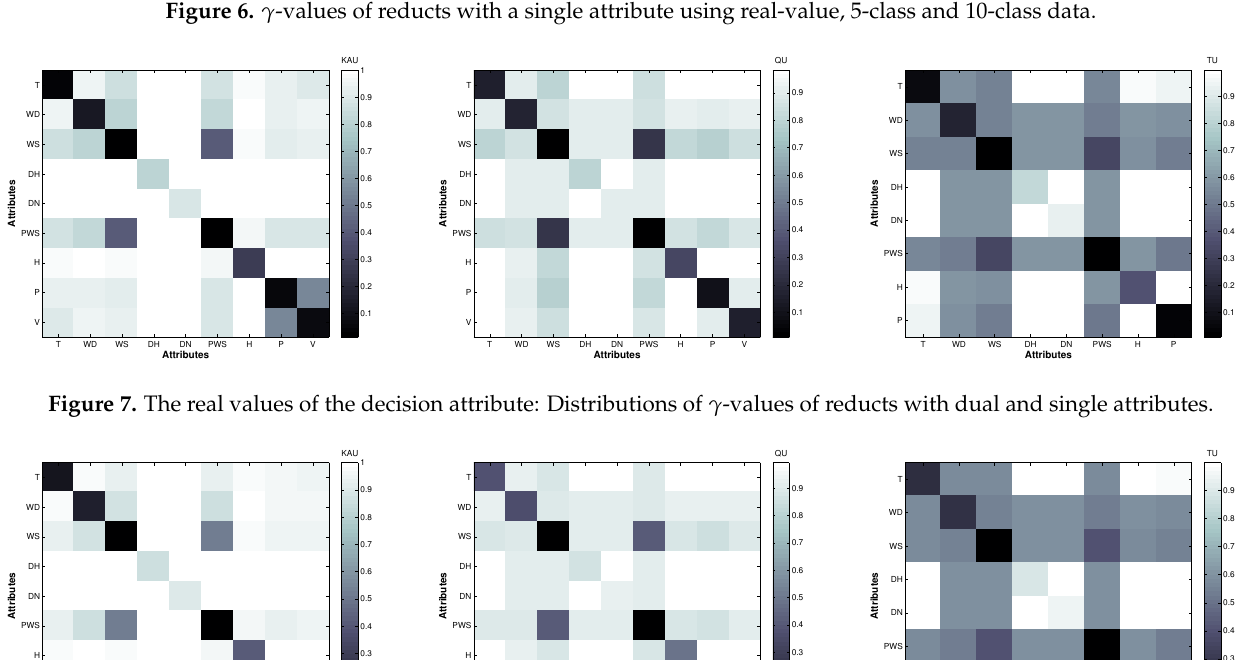
Figure 6. γ -values of reducts with a single attribute using real-value, 5-class and 10-class data.